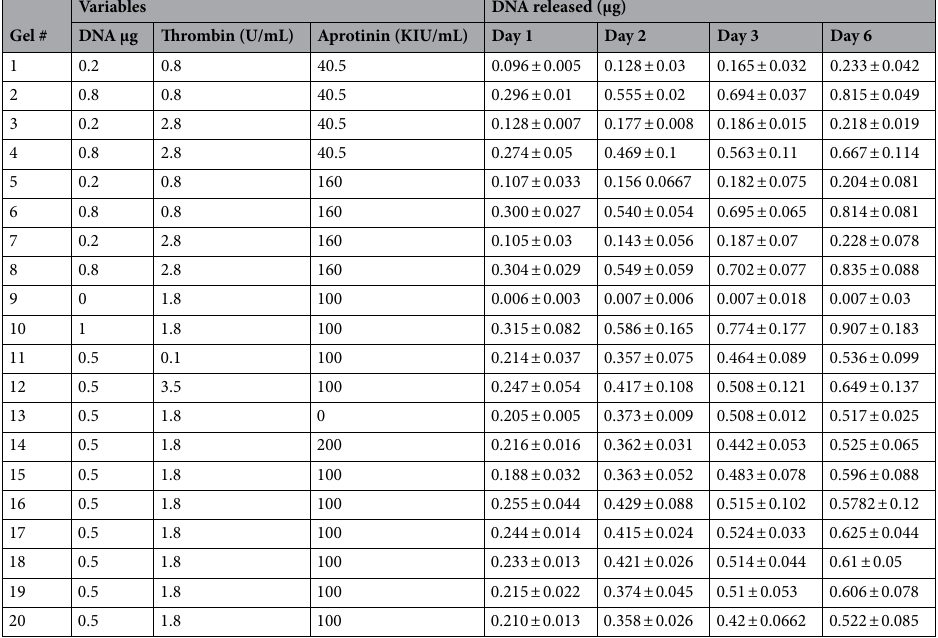
Table 1. Quantification of DNA released over time from fibrin hydrogels. Fibrin hydrogels prepared using different concentrations of DNA, aprotinin and thrombin, were incubated in PBS. DNA released was quantified at different timepoints. N = 3.